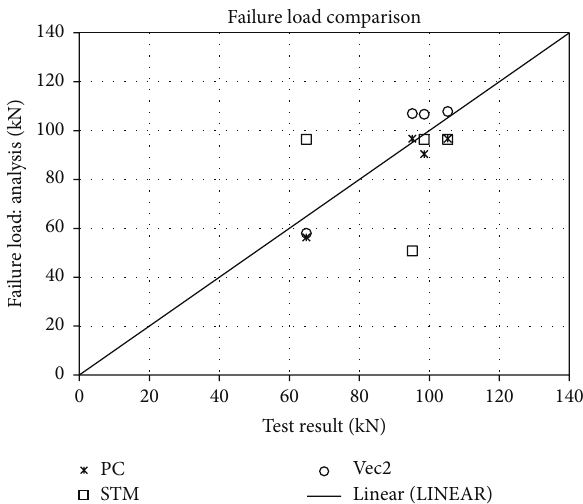
Figure 7: Dissemination of failure load values for experimental and analysis results.